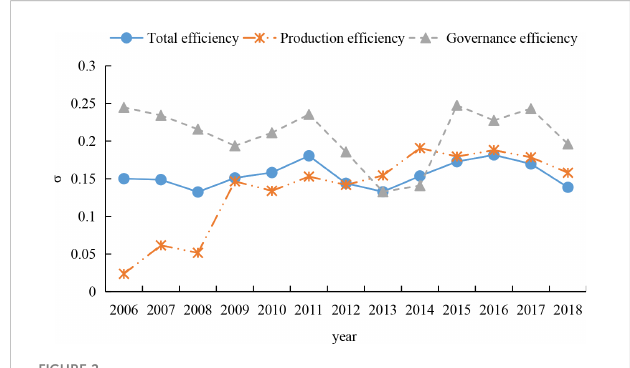
FIGURE 2 Trends of s convergence coef fi cients of marine green economy ef fi ciency at different stages.